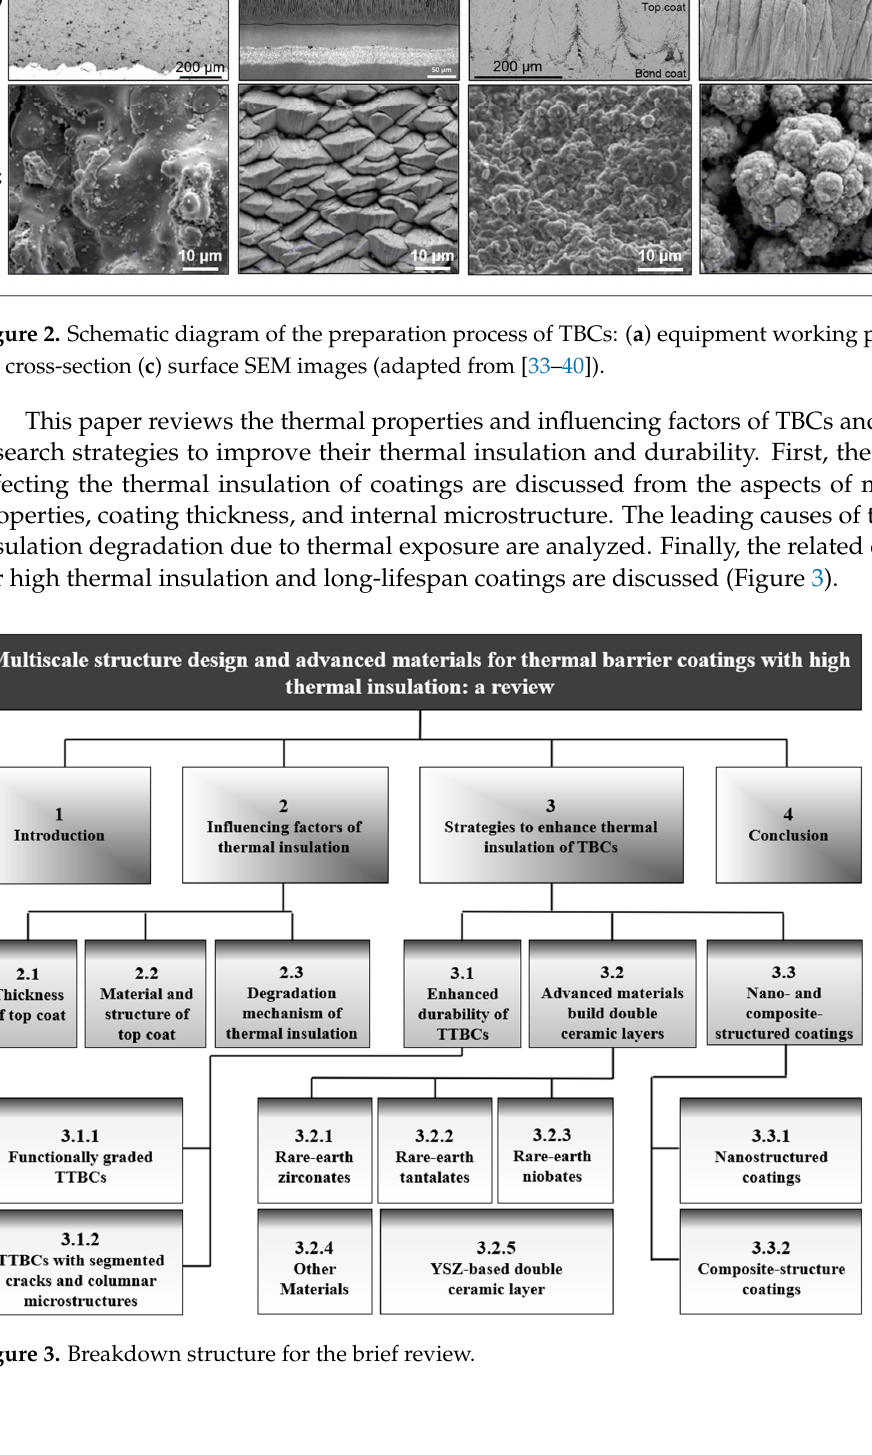
Figure 1. Typical applications of TBCs in industrial fields.